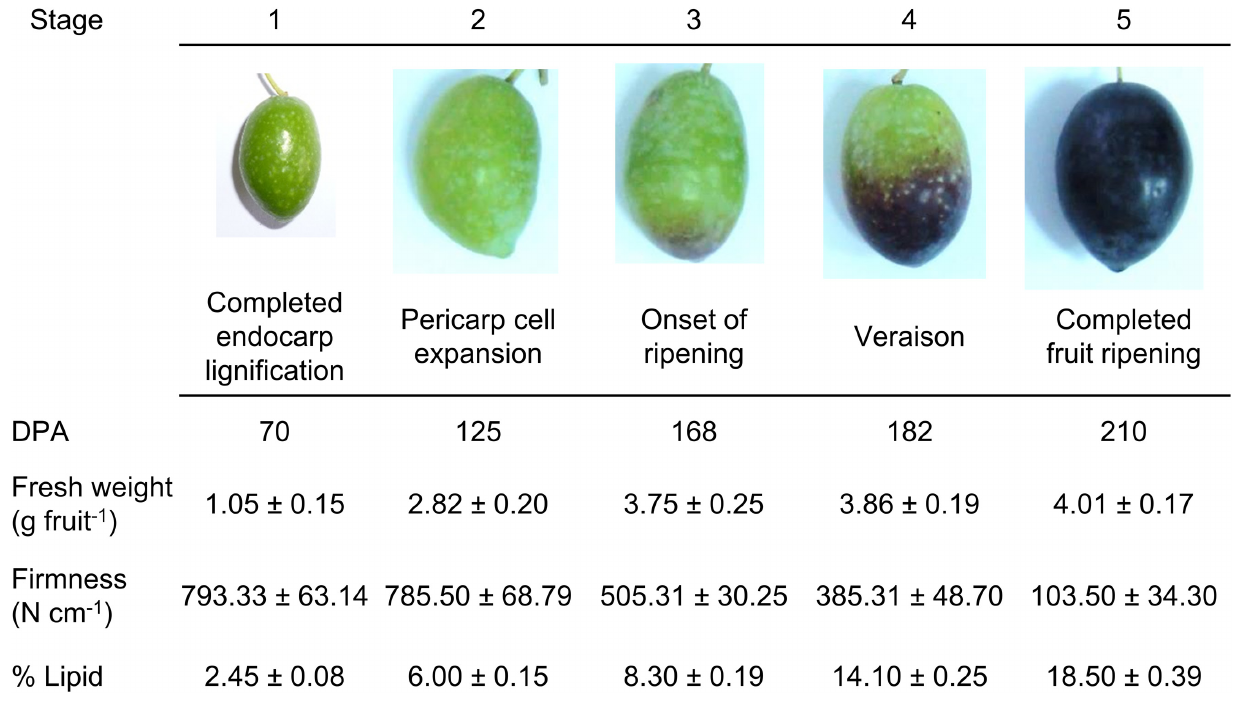
FIGURE 1 | Developmental stages of the olive fruit of the cv. Picual. Stage 1: ‘completed pit hardening’; Stage 2: ‘peak of cell expansion’; Stage 3: ‘the onset of ripening’; Stage 4: ‘veraison’; Stage 5: ‘fully ripe.’ DPA: days post-anthesis. Fresh weight and firmness measurements were performed on whole fruits. Lipid content measurements were performed on fruit pericarps. Asterisks indicate statistically significant changes ( P < 0.05) with respect to the preceding point. Data are the means of three independent experiments ±